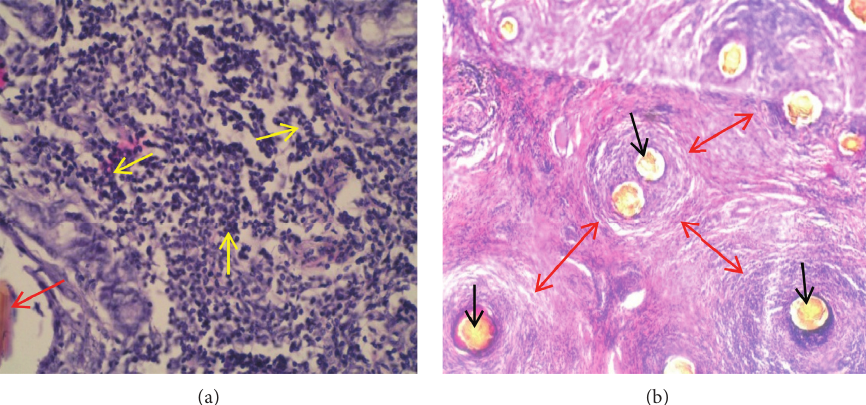
Figure 14: (a) Numerous mononuclear cells (yellow arrows), mainly macrophages, lymphocytes, and plasma cells, infiltrating areas where Opuntia stricta spines (red arrow) are located in severe abomasitis (x100). (b) Multifocal O. stricta thorns (Black arrows) and associated coalescing foreign-body granulomatous reactions (red arrows) in the pyloric region of a goat with severe chronic abomasitis